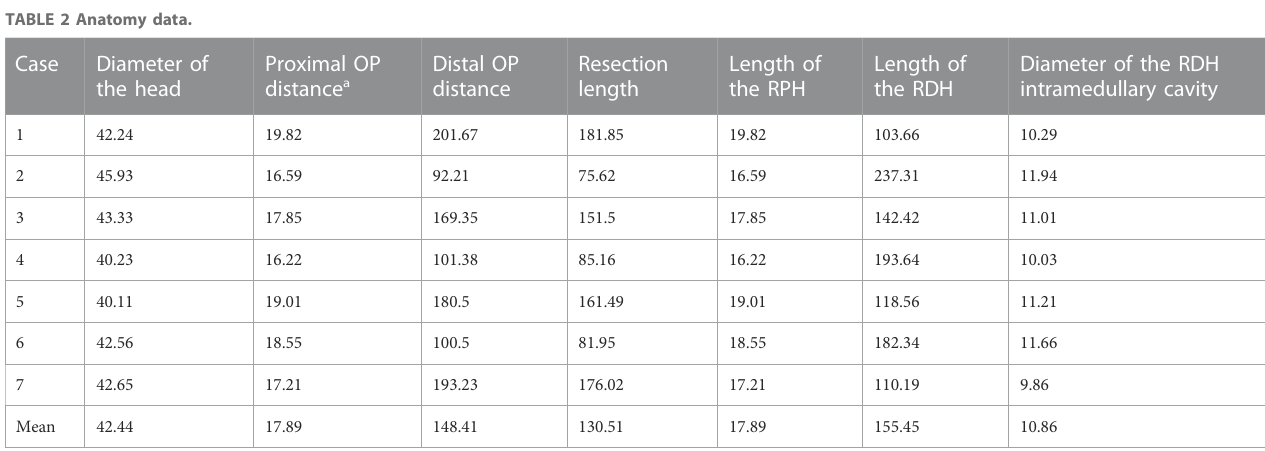
TABLE 2 Anatomy